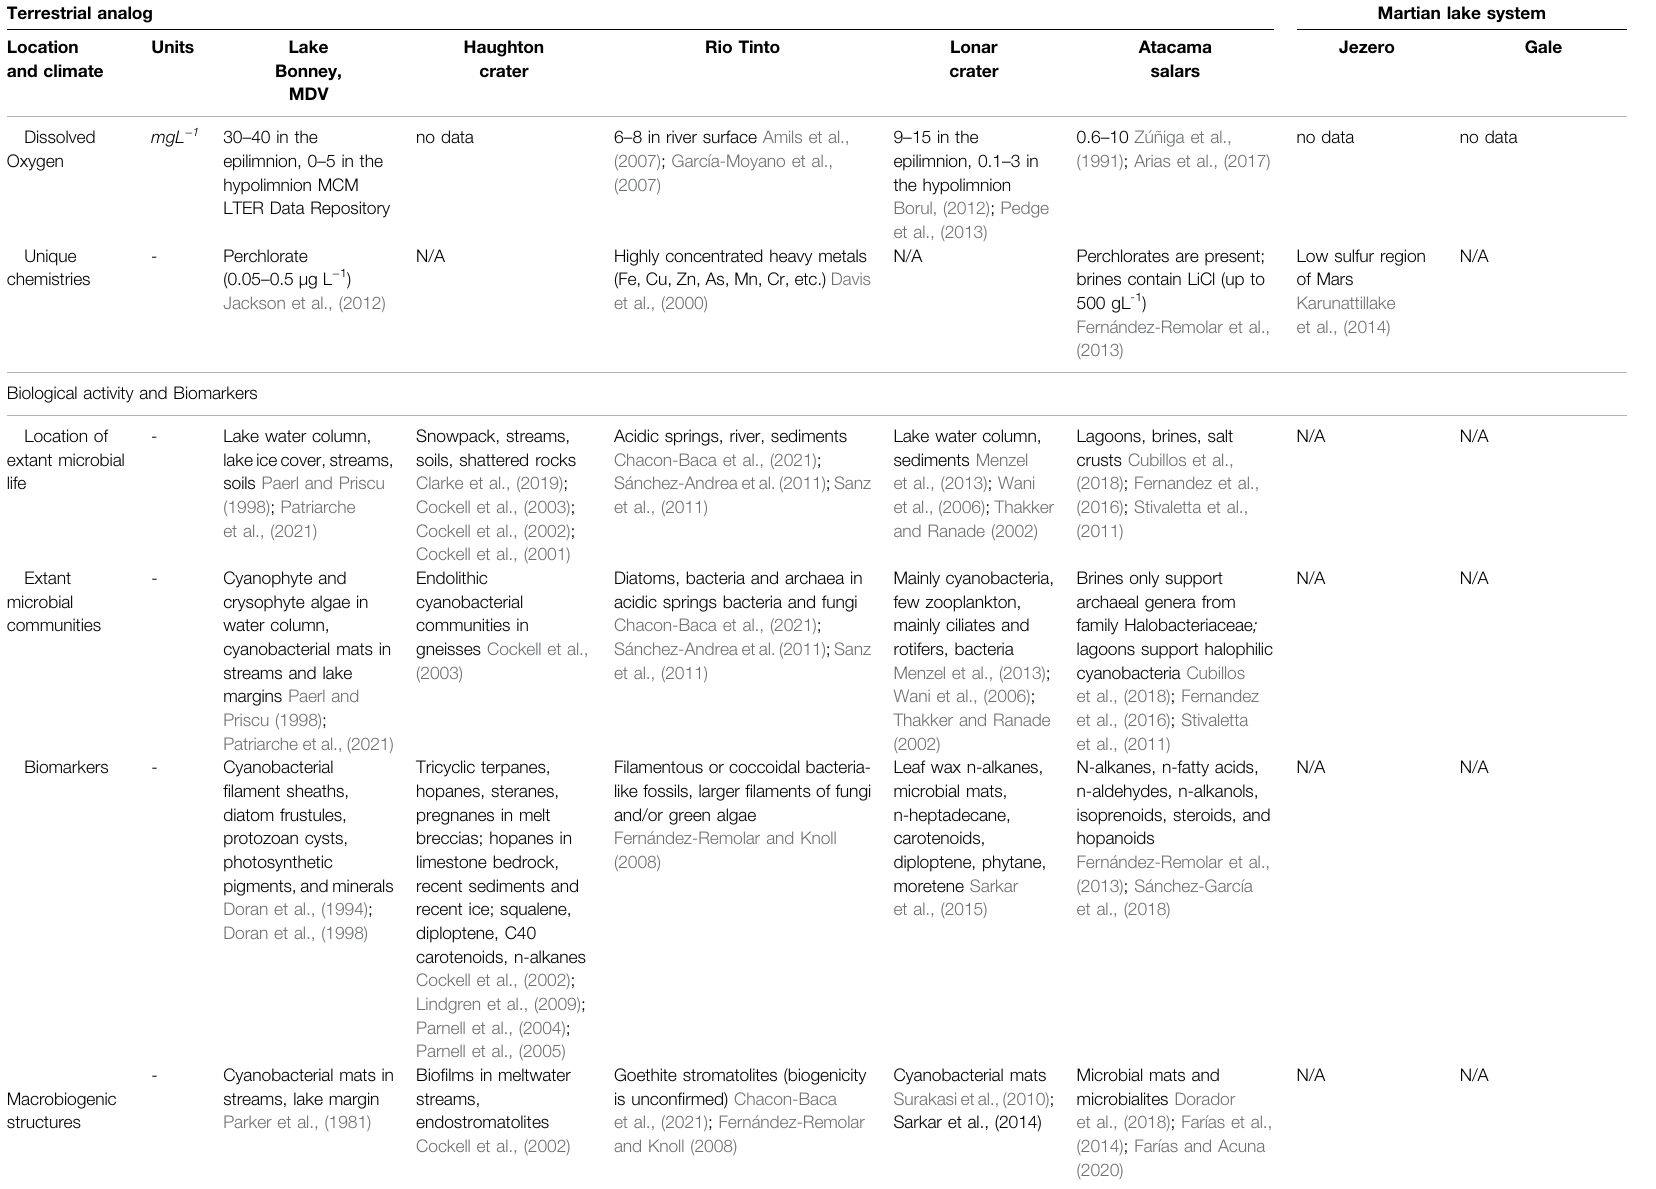
TABLE 1 | ( Continued ) A cross-site comparison of selected environmental, mineralogical, chemical, and biological